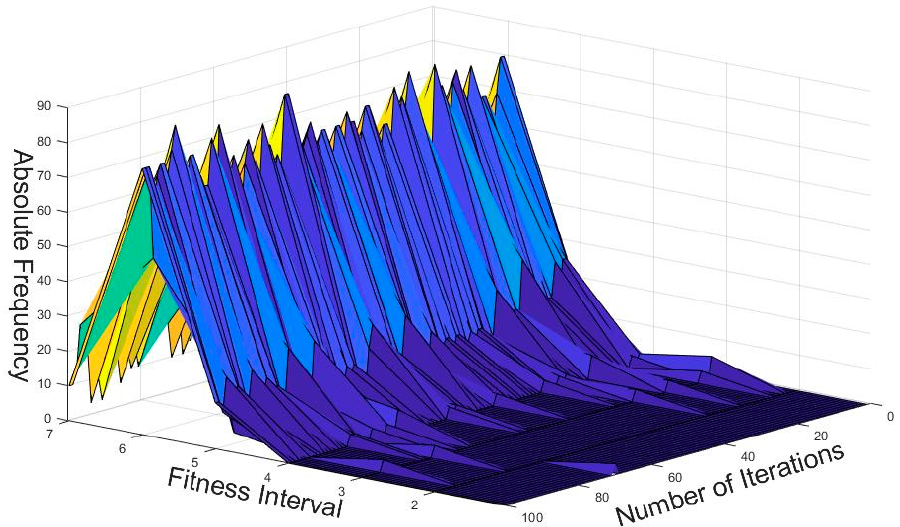
Figure 7. Absolute frequency histogram of swarm fitness.